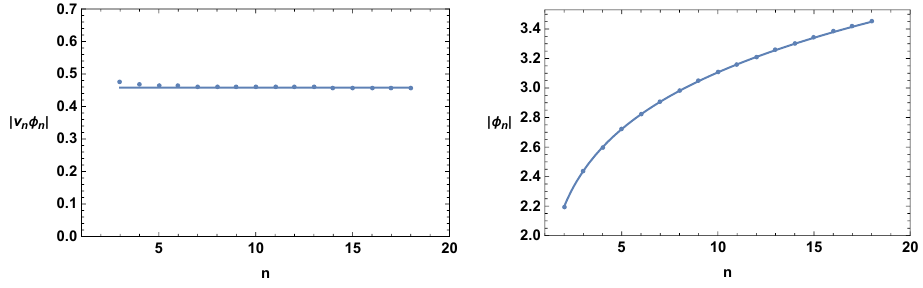
φ | (left) and | φ | (right) as a function of bounce number n . Figure 6: Behavior of | v n n n Dots are numerical results corresponding to the potential considered previously in Fig. 1, extended to larger values of ρ to capture more bounces. The solid lines are fits to the analytic expression (36). The analytic result fits both plots with only two free parameters in total: b and n . The constant b ≈ 0.458 is determined by the o φ | . The field values | φ | are then fit to (37) with p = 7 and constant value of | v n n n ˜ b ≈ 2.15 fixed, leading to n ≈ o